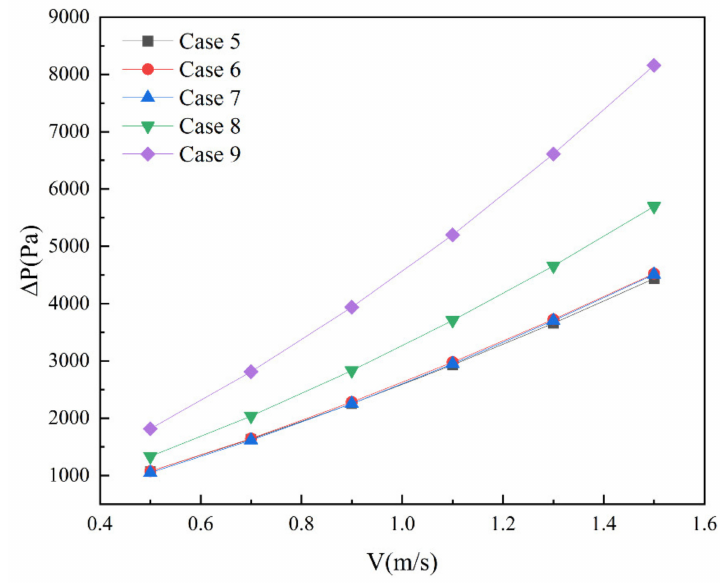
Figure 13. Pressure drop of Cases 0–4 at different inlet velocity.